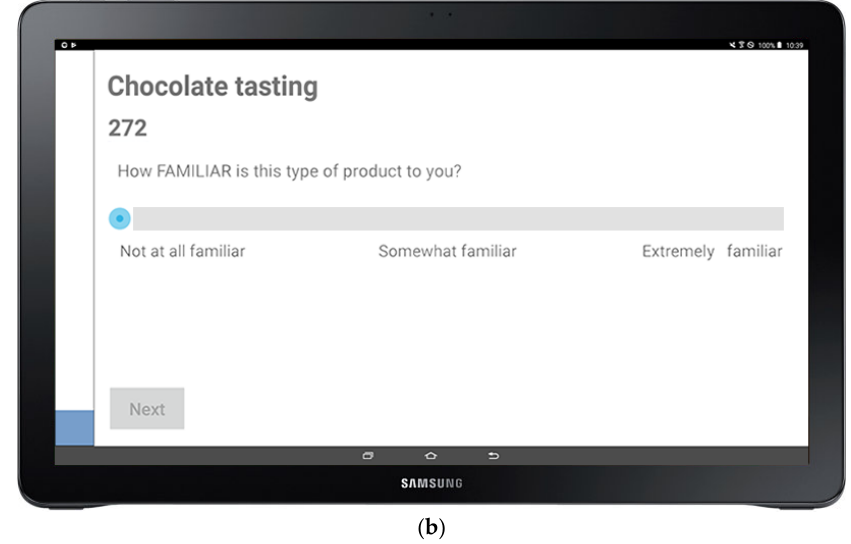
Figure 3. Sensory form as presented in the biosensory app for each sample where: ( a ) shows the categorical scales, and ( b ) the 15-point continuous scale. Sensors 2018 , 18 , x